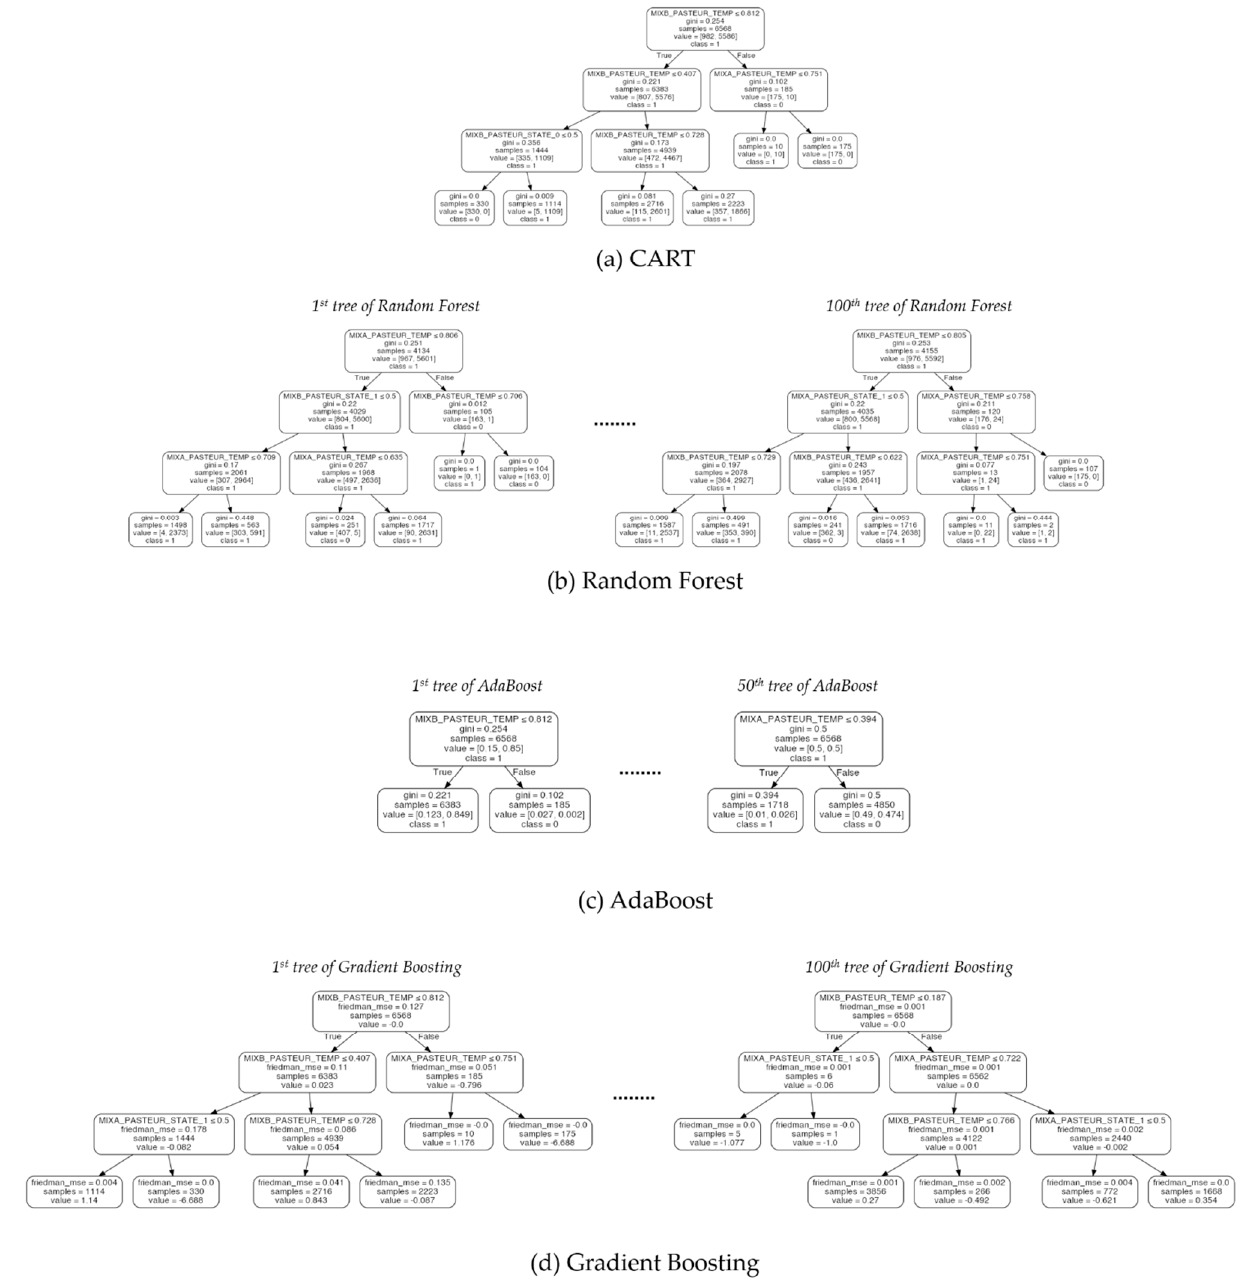
Figure 8. Illustration of decision trees generated by four tree-based algorithms (CART, Random Forest, AdaBoost, and Gradient Boosting) for the Pasteurizer dataset. Ensemble methods producing different decision trees are illustrated by visualizing only the first and last models. Table 7. Training and test performances of DIMPLED and tree-based algorithms for CNC and Pasteurizer datasets.